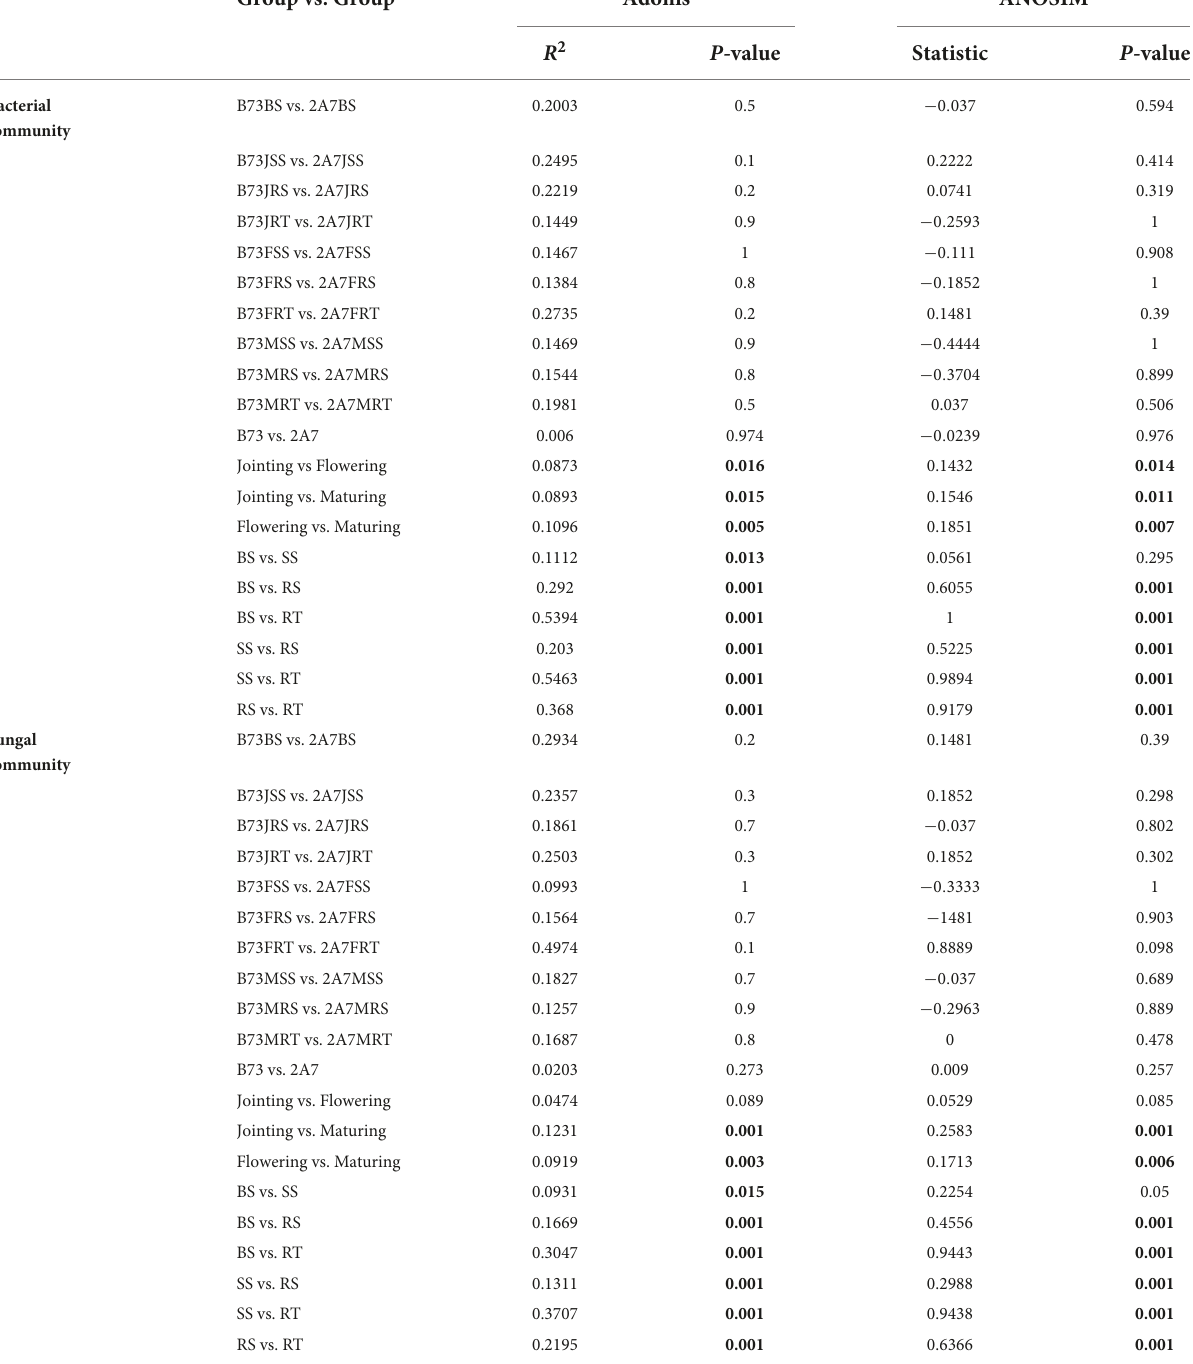
TABLE 2 Significance tests of microbial communities’ structure between samples. Group vs.